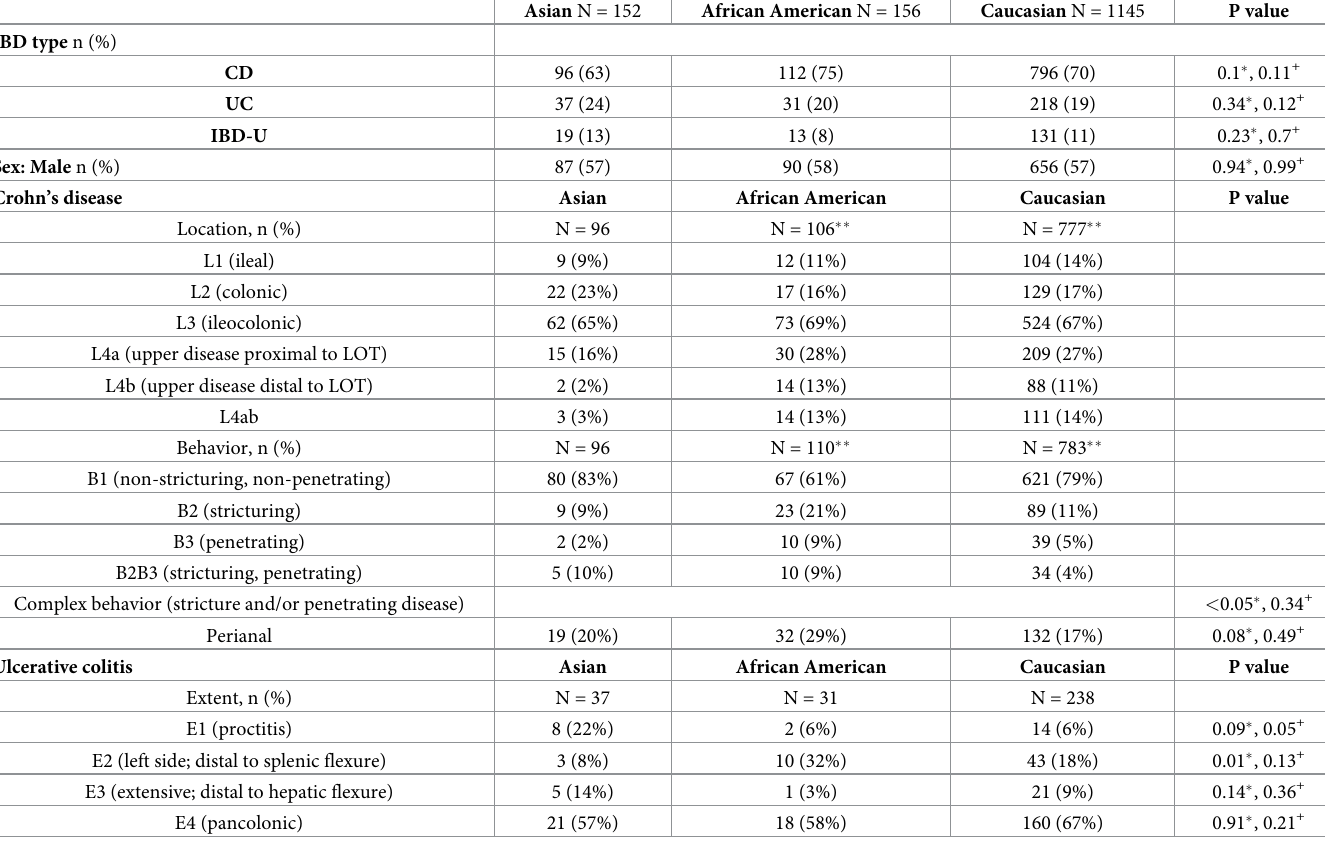
Table 1. Baseline characteristics of Asian American cohort vs. a control cohort of non-Asian (African American and Caucasian) patients from our center’s ICN